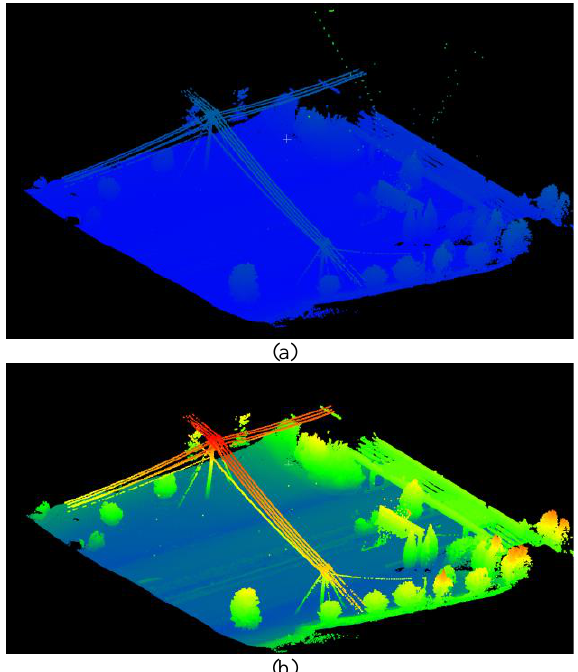
Figure 2. Eliminating the noisy points inside each created section; (a) a noisy sample section, (b) a free noisy point